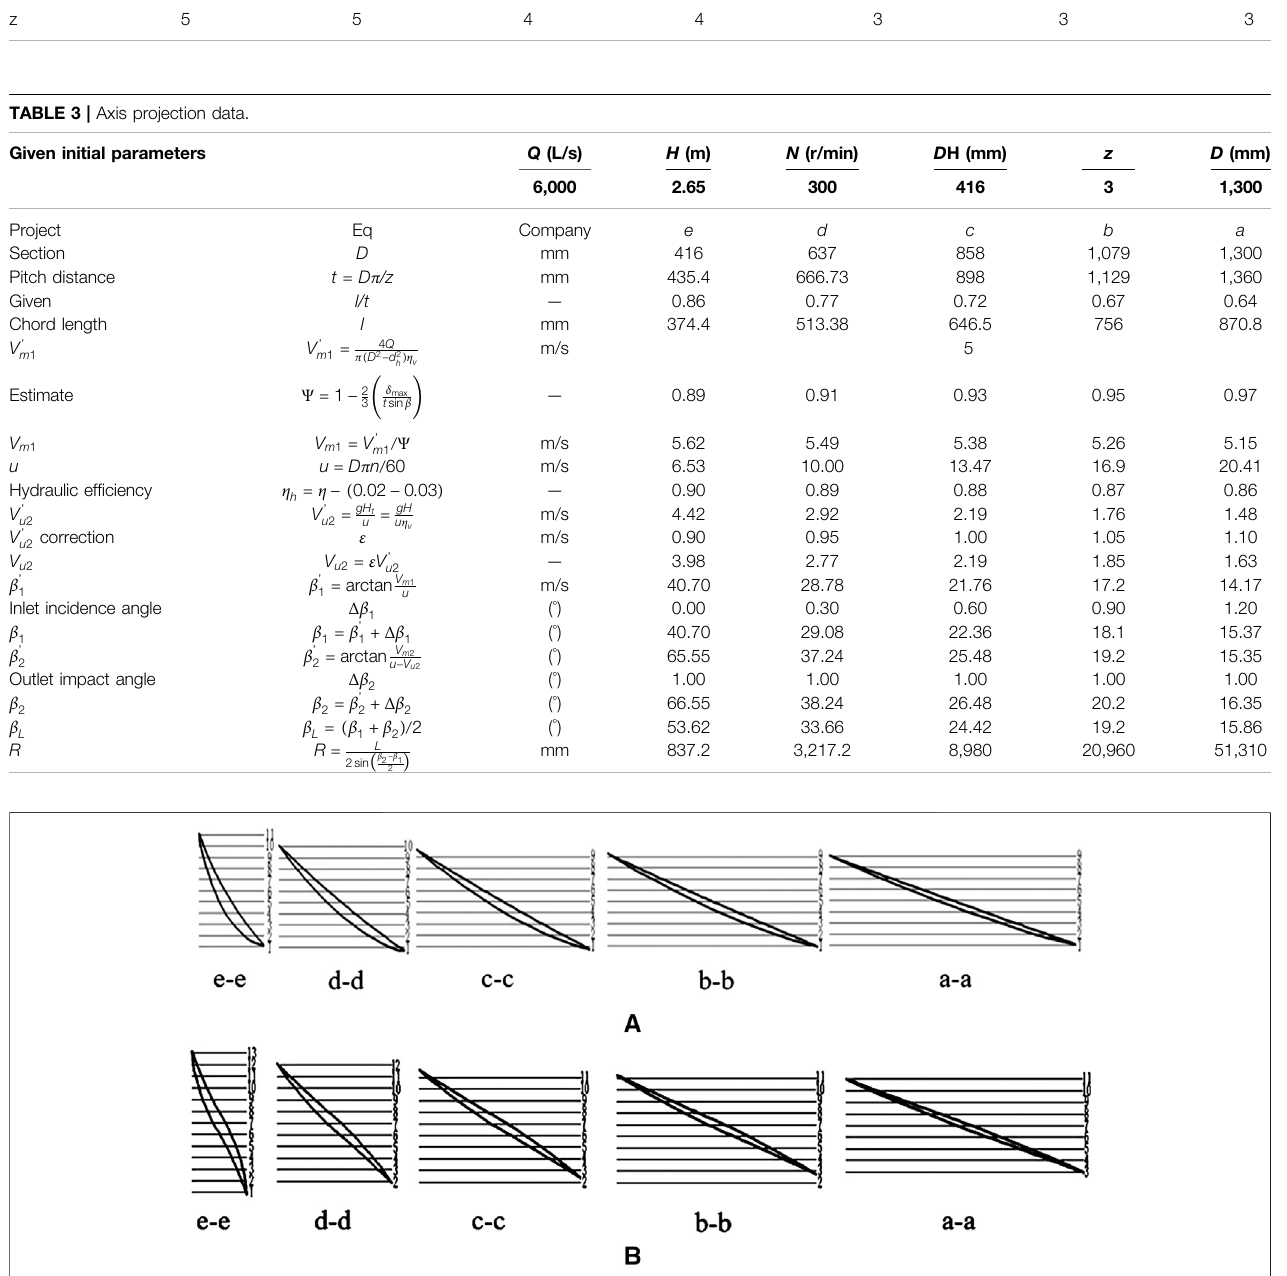
FIGURE 3 | Airfoil section transform diagram. (A) According to the above table axial projection data. (B) According to the blade airfoil change method. diagram in the table, as shown in attached Table 4 . From the section. Z /mm is the distance from the contour line to the impeller hub to the rim, the airfoil sections 5-1, 4-1, 3-1, 2-1, and centerline of the shaft surface. And θ / ° is the circumferential curvature of the L transformation. The data of the working 1-1 are sequentially plotted on the contour line of the working surface and the upper airfoil point are imported into the surface, and records 5-2, 4- 2, 3-2, 2-2, 1-2 as the points on the CREO drawing software through the offset coordinate system back-contour line. L /mm is the distance from the working surface to obtain the points of the fi ve airfoil sections and the back side. of the airfoil contour line and the point on the back side to the The spatial three-dimensional data points and models of the center line of rotation. R /mm is the radius of the airfoil cylindrical